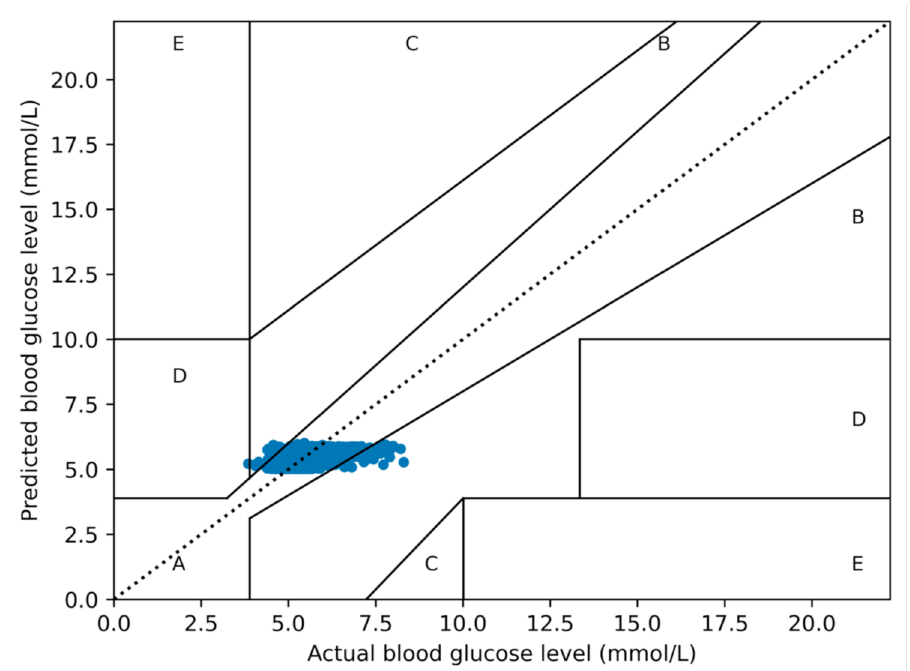
Figure 10. The EGA diagram for the RG_AdaBoost model.